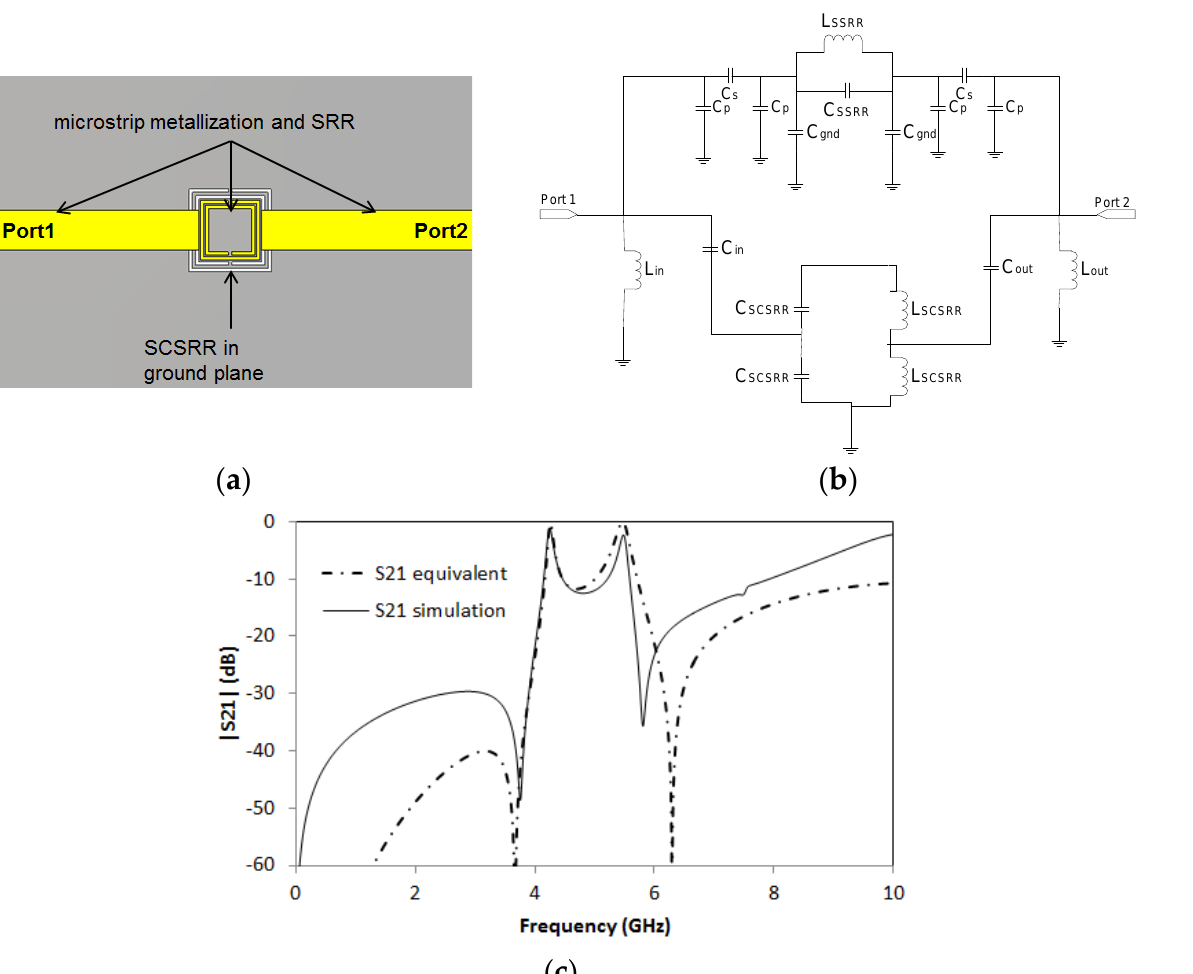
Figure 5. Double frequency resonator. ( a ) Top view overlapped layers. ( b ) Equivalent circuit model. ( c ) Simulated S21 (solid black line) and simulated S21 for equivalent circuit model (dash-dotted line).